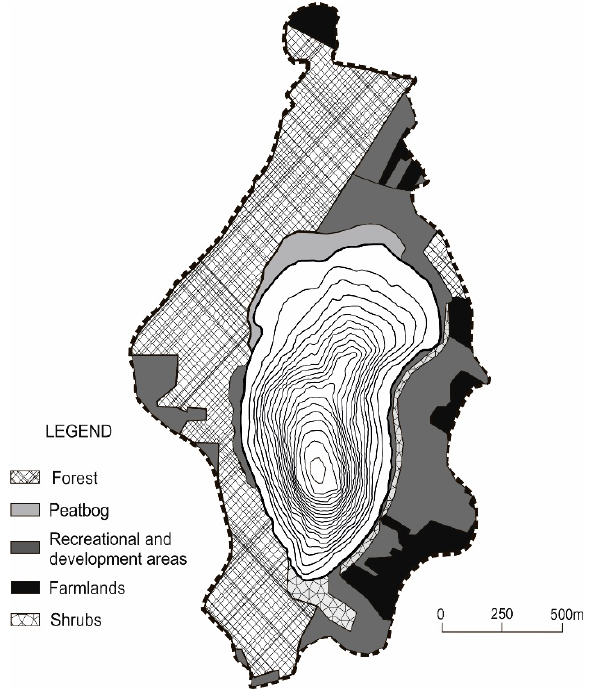
Figure 2. The land use structure in the catchment of Lake Piaseczno in 2010. Adapted from [38].